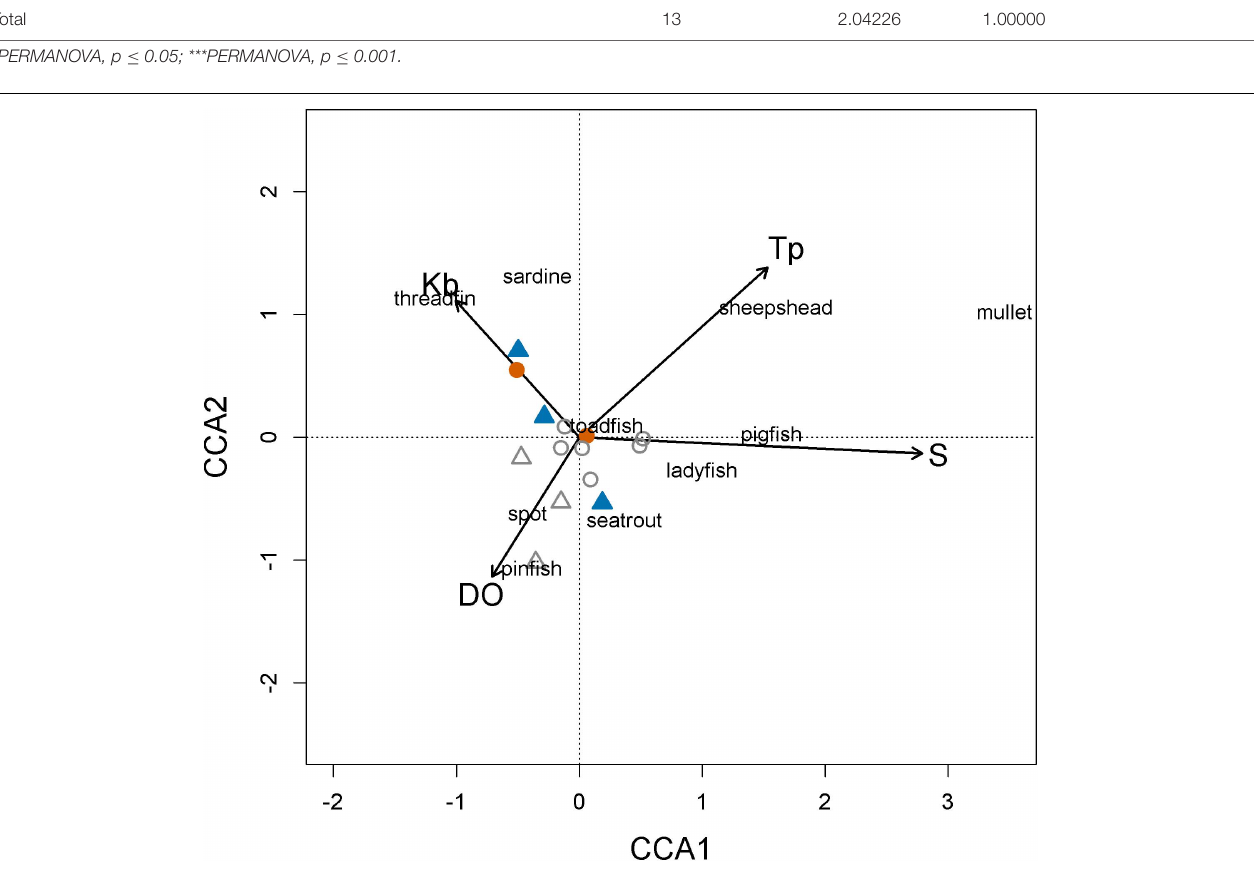
FIGURE 5 | Canonical correspondence analysis (CCA) of the prey assemblage from purse seine catches, from June 2018 to March 2019. Symbols: • = summer red tide conditions,